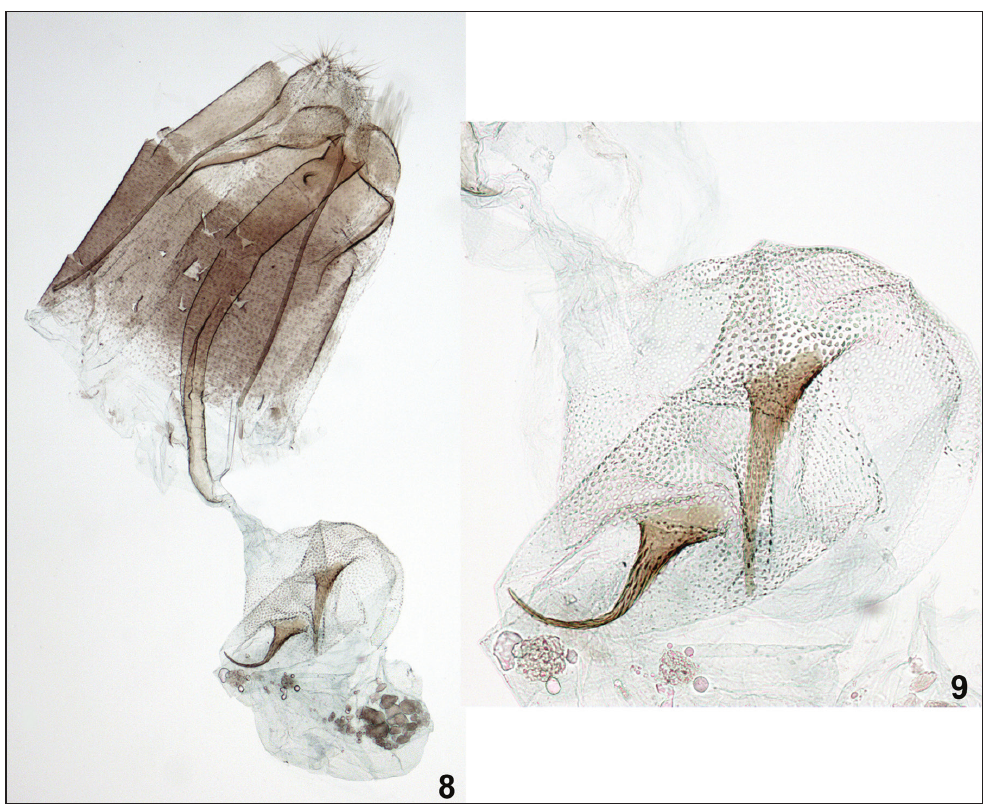
Figures 8–9. Platyptilia galicicaensis sp. n.: 8. female genitalia (GPJJ201604); 9. corpus bursae with a pair of Male genitalia (Figs 4–7). Five specimens examined. Uncus skittle broad basally with numerous setae, narrowing distally, with rounded apex, slightly curved towards valva. Tegumen a broad subov - al plate, anterior margin with broad obtusely V-shaped cleft with both sides rounded, lateral margins rounded, posterior margin with broad medial cleft, both sides medially concave. Valva symmetrical, parallel-sided, 4× longer than wide, with numerous, long setae, apex rounded. Sacculus extending nearly to apex of valva, basal third broad, parallel-sided, medial third tapering to narrow apical third. Saccus a broad quadrangular plate, anterior margin broadly U-shaped. Anellus arms relatively stout and strongly sclerotized, strong lateral projection 1/3 from base, apical half gradually tapered to digitate apex. Phallus strongly curved throughout its length, basally inflated with sub-basal process, distal part tube-like slightly tapered towards blunt apex, large group of spinule-like cornuti in vesica. Female genitalia (Figs 8–9). Two specimens examined. Papillae anales oval, with few setae. Apophyses posteriores 2× longer than 8 th tergite. Apophyses anteriores short, broadening basally. 8 th sternite consisting of pair of oval plates just posteriad of ostium bursae. Ostium bursae cup- shaped. Antrum tubular, sclerotized part 8× longer than membranous part of ductus bursae, poste - rior half almost parallel-sided, anterior half slightly tapering towards bursa. Membranous part of ductus bursae posteriorly narrow then widening towards corpus bursae. Corpus bursae roundish